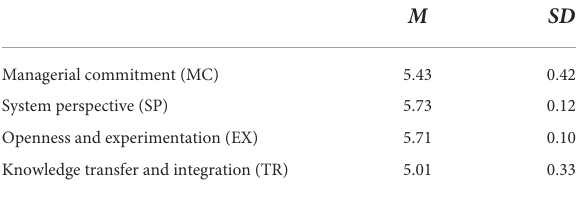
TABLE 2 Dimensions of organizational learning ( n =